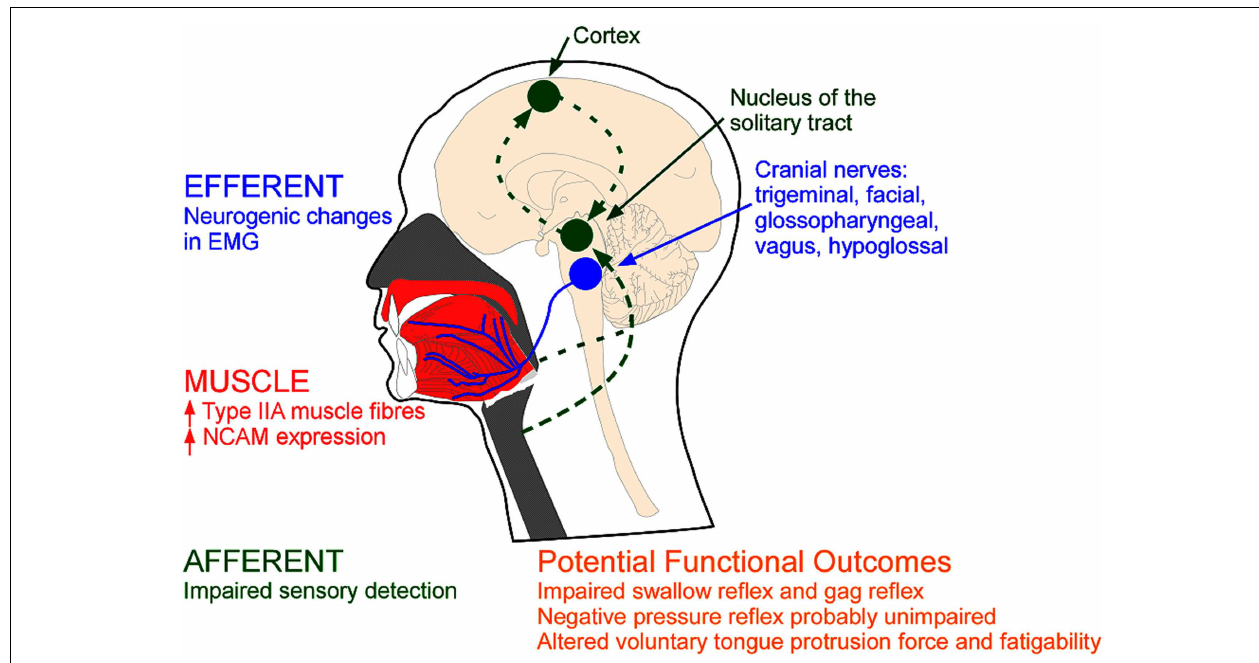
(EMG) of the upper airway muscles innervated via the cranial nerves (blue); AFFERENT: changes in sensory pathways (green). NCAM=neural cell adhesion molecule.